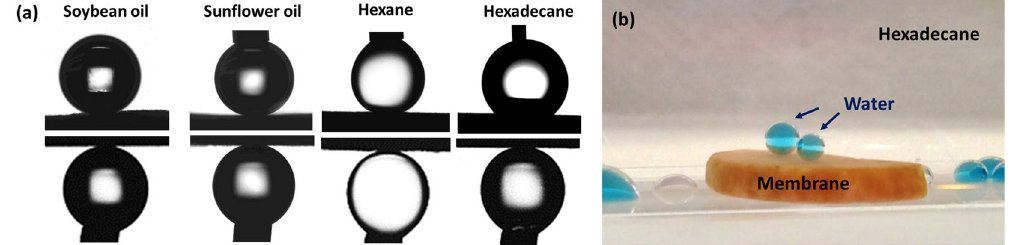
Figure 3. ( a ) Droplet profiles for wetting properties of the diatomite membrane in oil-water systems. Upper row: water droplets in soybean oil, sunflower oil, hexane and hexadecane, respectively. Lower row: the droplets of the aforementioned oils in water. ( b ) Photograph of a prewetted membrane by hexadecane. The two blue- dyed water droplets showed high contact angles on the membrane. The droplets surrounded by the membrane are those rolling off the surface of